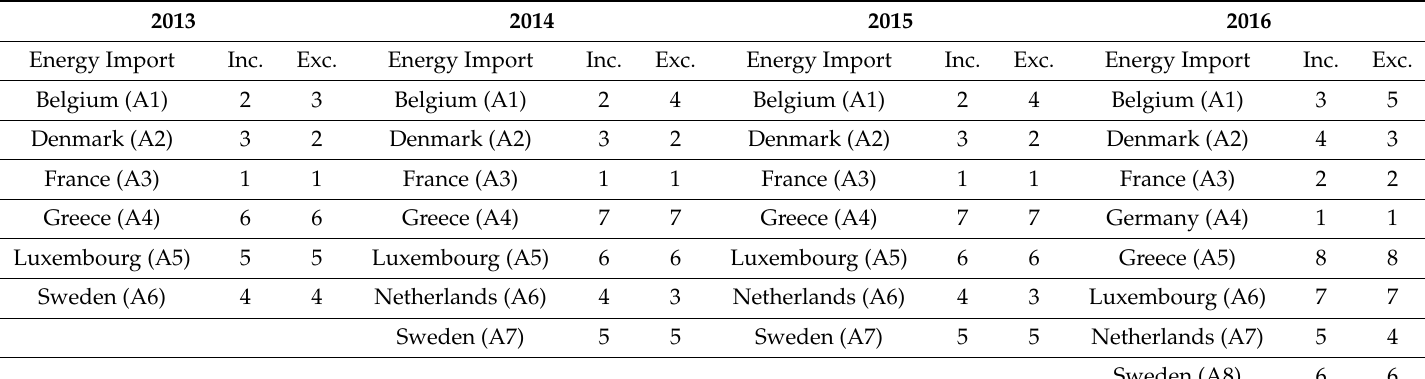
Table 17. Ranking transport import performance of the EU countries in case of including and excluding the energy trade. 2013 Energy Import Inc.